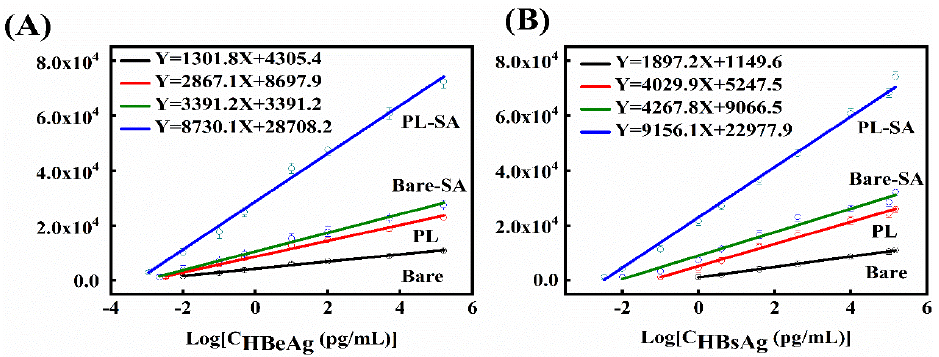
Figure 4. Semilogarithmic curve of the chemiluminescent intensity vs the concentration of Hepatitis B e antigen (HBeAg) ( A ) and hepatitis B surface antigen (HBsAg) ( B ), for a porous-layer modified optical fiber sensor with signal amplification (PL-SA), a PL fiber sensor without SA (PL), a normal optical-fiber sensor without SA (bare) or with SA (bare-SA). Each data point is an averaged result of three replicated assays. Linear fitting of each curve is indicated in the figure.